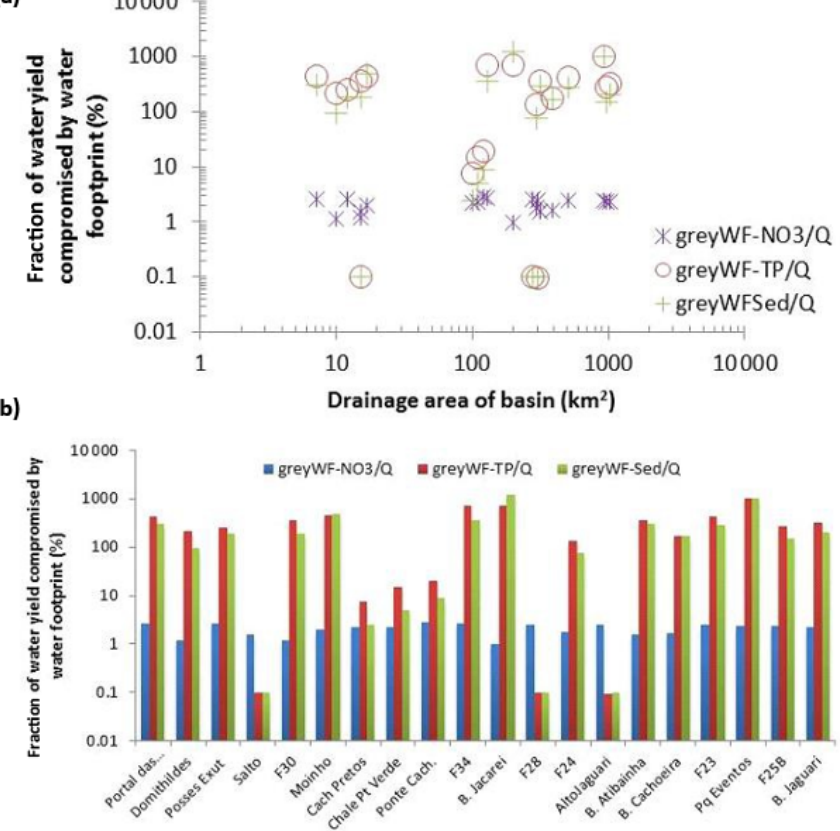
Figure 12. Fraction of water yield (mean Q ) compromised by the grey water footprint of nitrate (greyWF-NO3), total phosphorous (greyWF- TP) and sediments (greyWF-Sed) vs. drainage area (a) and vs. selected sub-basins (b)